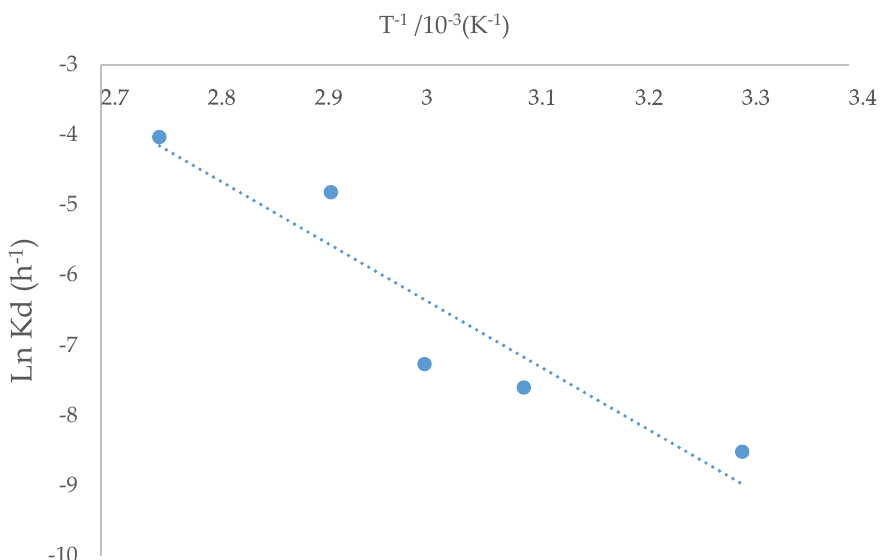
Figure 7. Arrhenius graph for chalcopyrite extraction using ionic liquid at 20% ( v/v ) and 100 g/L of Br − .